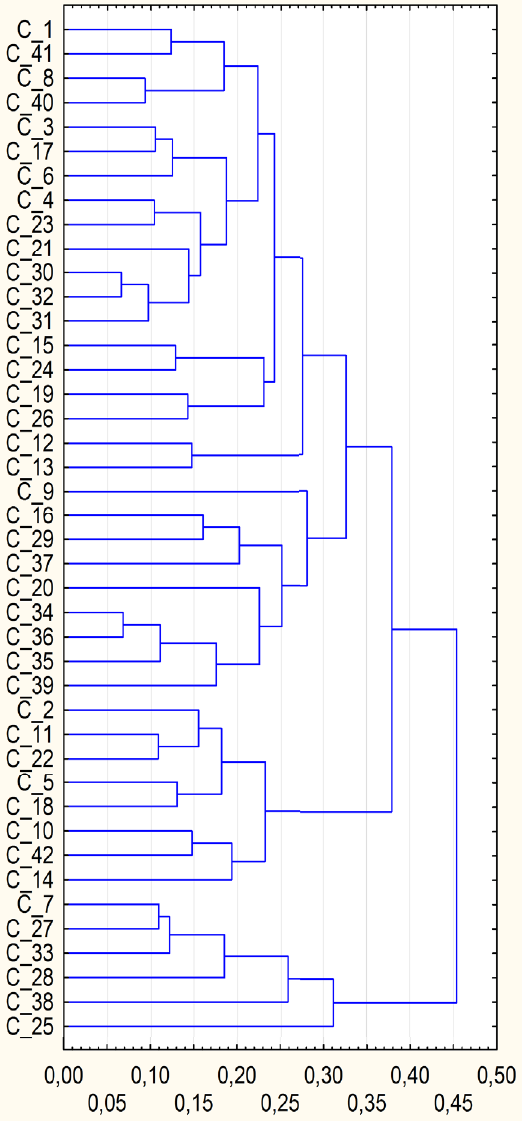
Figure 2. Formation of 42 curricula into clusters Source: Statistica 10 cluster model output based on authors’